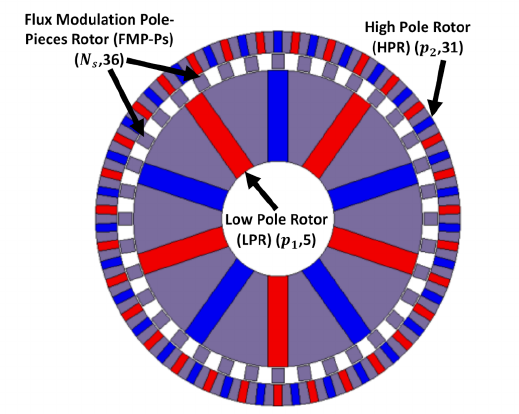
Figure 4. Interior PM FM-CMG.